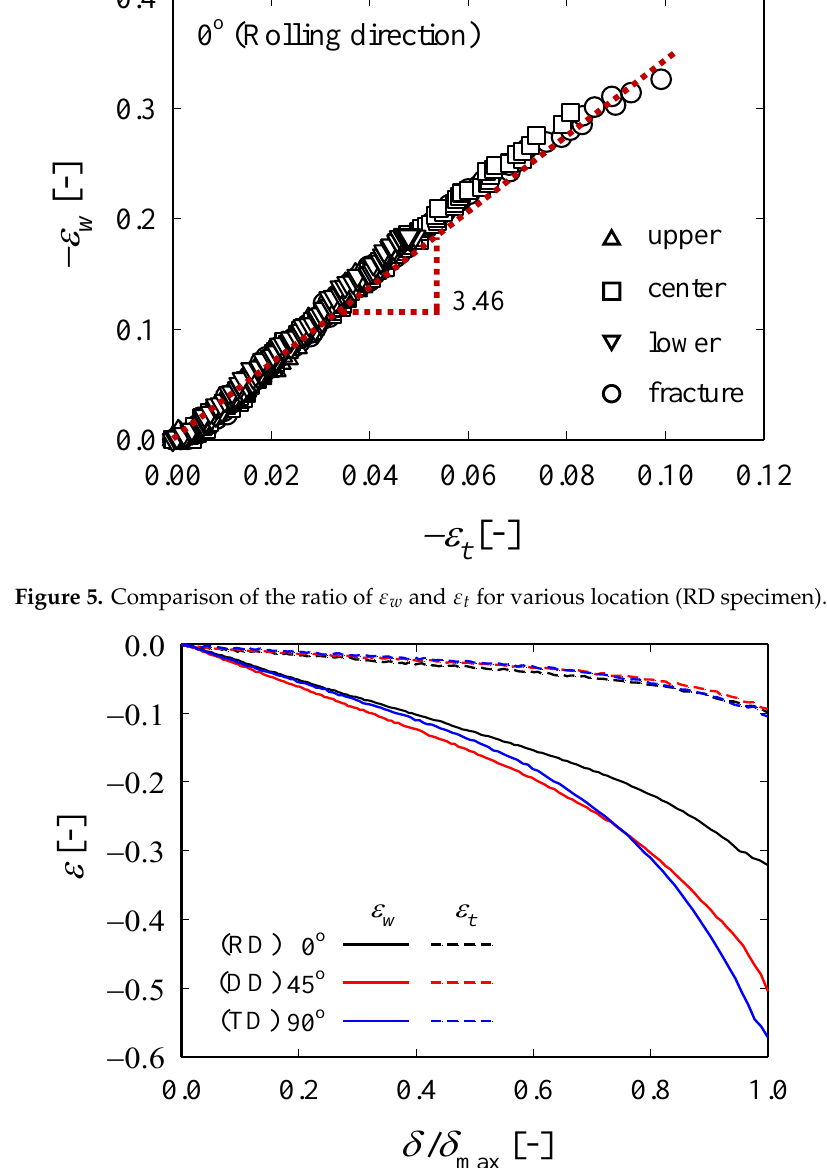
Figure 6. Evolution of ε w and ε t for fracture point from the uniaxial tensile tests at RD, diagonal direction (DD), and transverse direction (TD) specimen.